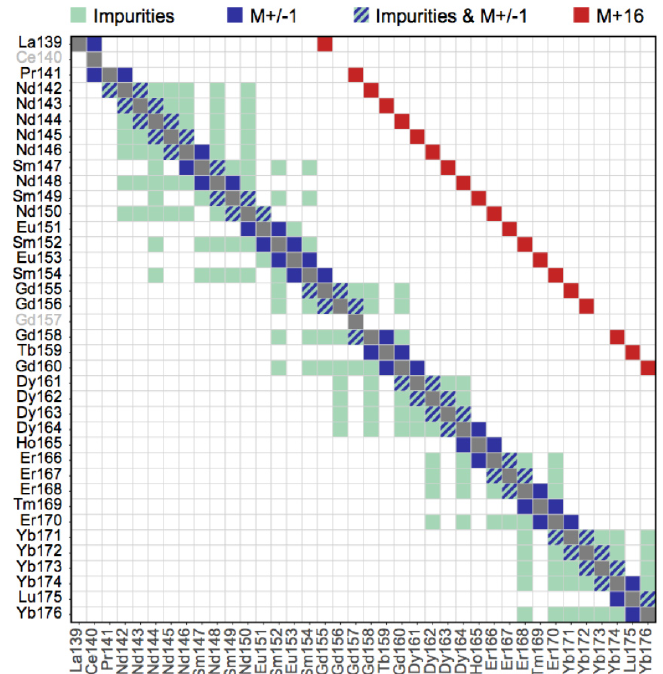
Figure 21. Heatmap of channel interactions expected to exhibit spillover. Included are only interactions that are sensible from a chemical and physical point of view: adjacent mass channels (abundance sensitivity), +16 mass channels (oxidation), and channels measuring isotopes